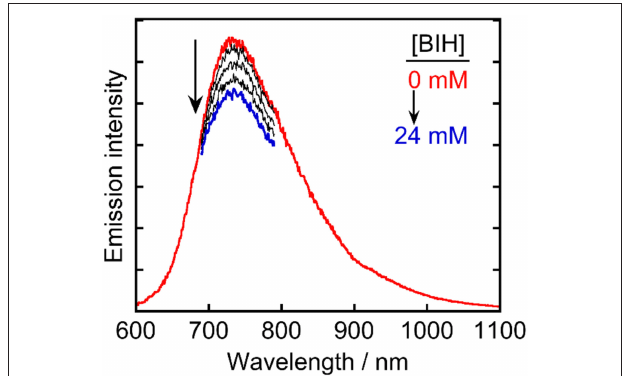
FIGURE 4 | Emission spectra of Ru(pic) in Ar-saturated DMA-TEOA (5:1 v/v) containing five different concentrations of BIH (0–24mm).